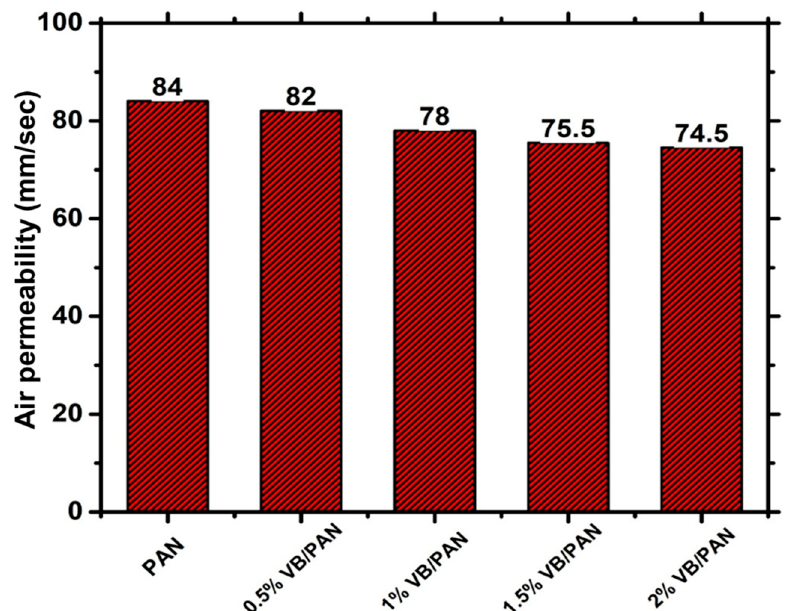
Figure 9. Air permeability of PAN and VB/PAN